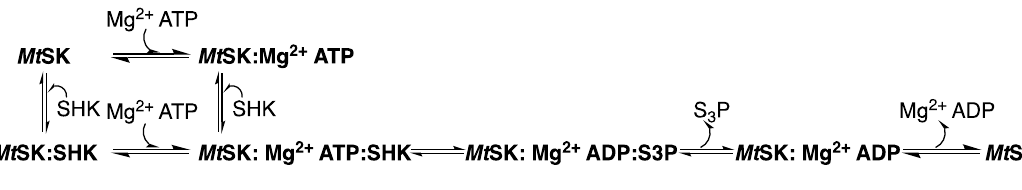
Figure 12. The kinetic mechanism of Mt SK.